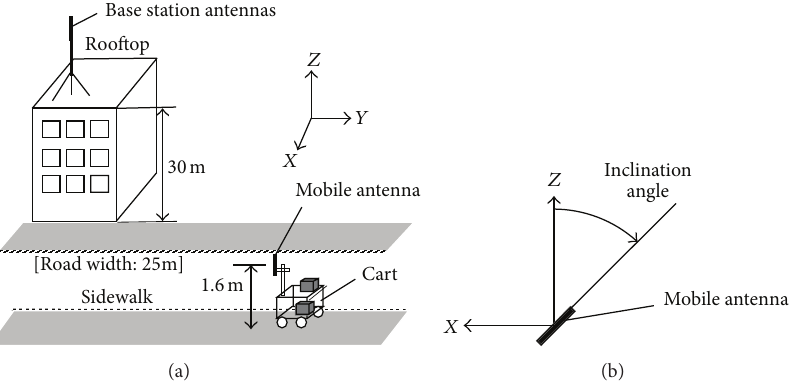
Figure 14: Scenario of RZL measurement in an urban street. (a) Measurement scenario. (b) Definition of inclination angle.